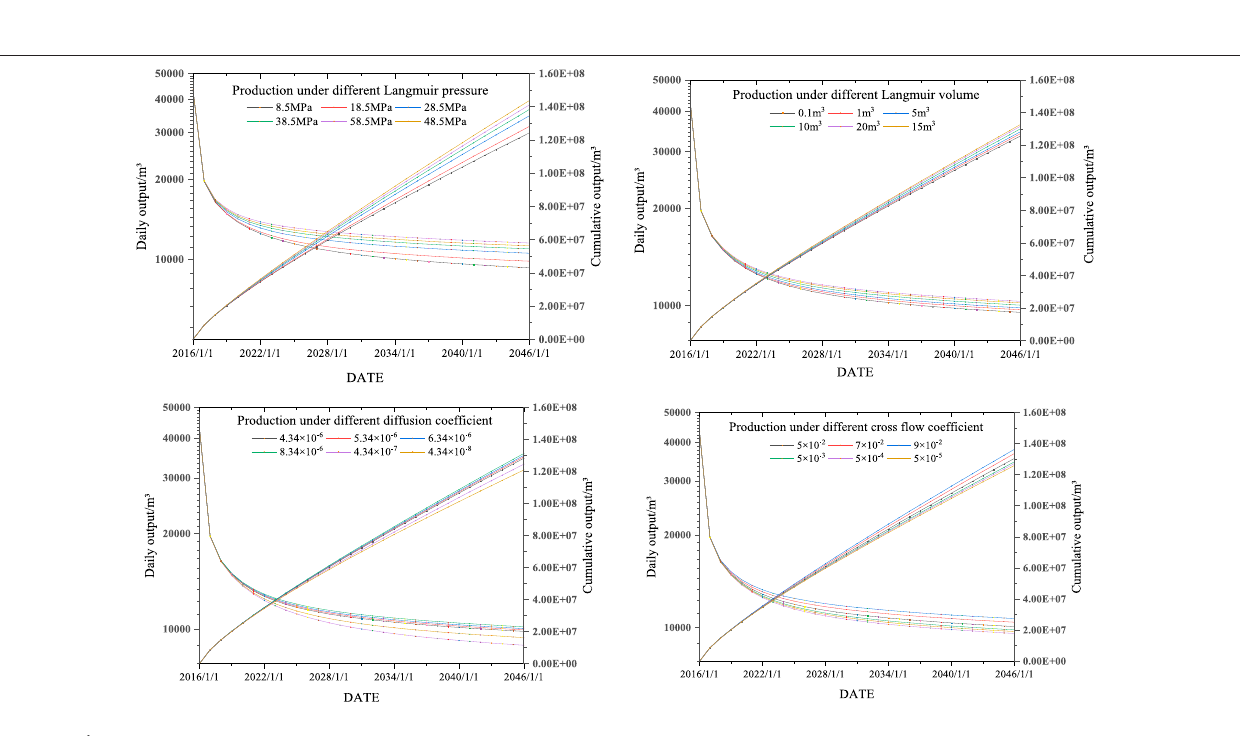
FIGURE 9 | Production of a well under diffusion